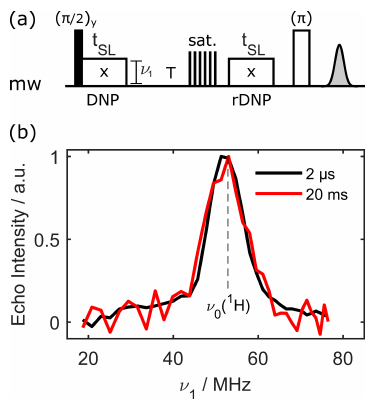
Figure 2. Transferring polarisation to nuclei and back to elec- trons. Panel (a) displays the pulse sequence. After an initial DNP step and a waiting time T , the electron spins are saturated. The next DNP step then leads to nuclear–electron polarisation transfer. The electron polarisation, which builds up along the spin-lock axis, can be read out with an echo. Timing details are given in Sect. 6. Panel (b) shows the repolarisation matching for 100µM OX063 in protonated water/glycerol at 80K. The microwave power during the first transfer is swept, while the second transfer is kept the same with optimised parameters. Different colours indicate different values of T